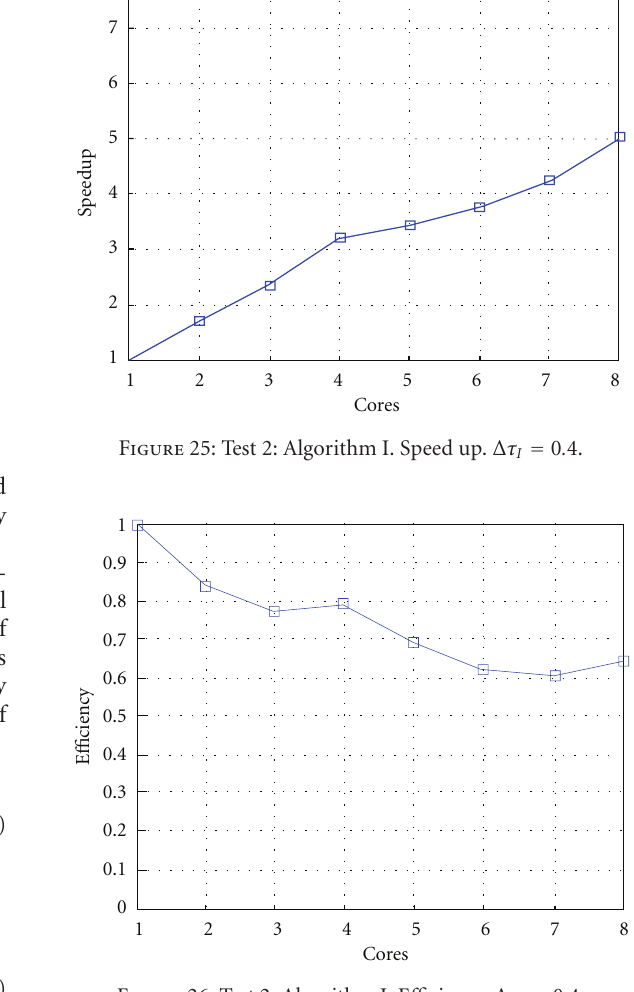
Figure 26: Test 2: Algorithm I. E ffi ciency. Δ τ I = 0 .